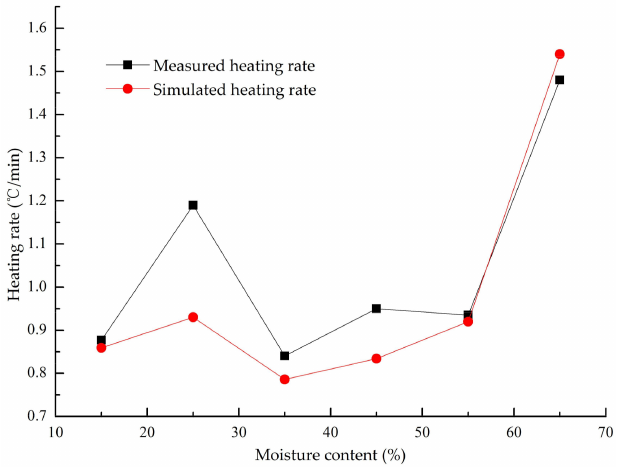
Figure 5. The comparison of simulated and measured heating